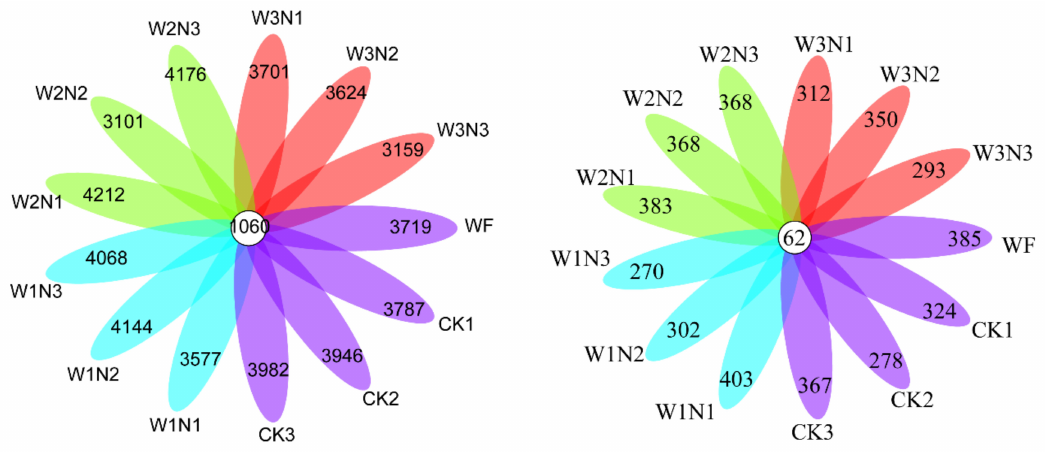
Figure 3. Statistics on the numbers of bacteria and fungi operating